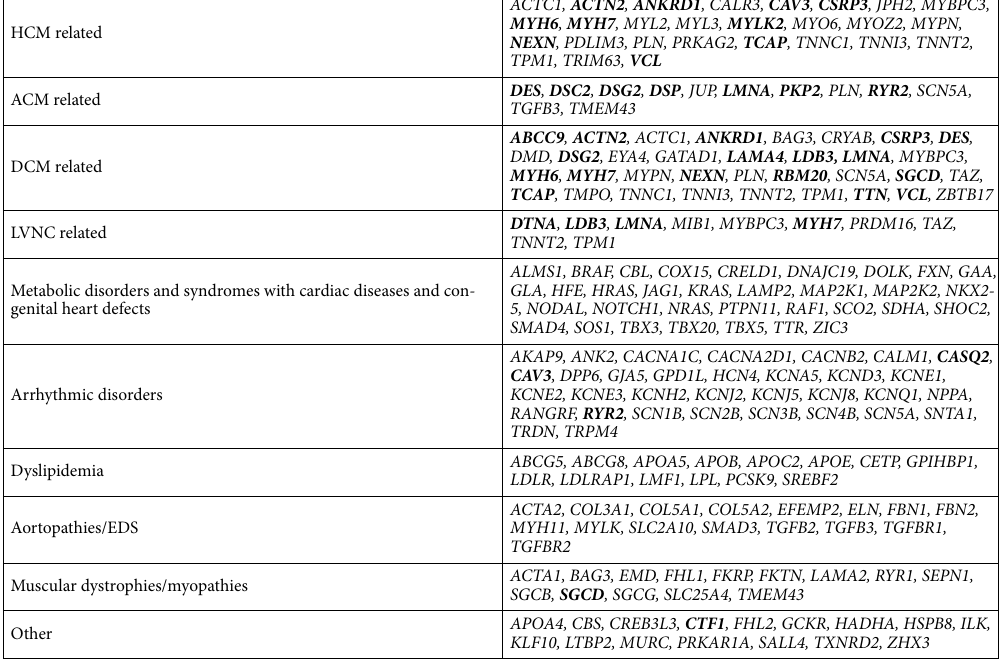
Table 1. Cardiac structure- and function-related genes sequenced in the panel classified by disease associations. Genes in bold had potentially disease related variants in sudden cardiac death victims. ACM arrhythmogenic cardiomyopathy, DCM dilated cardiomyopathy, EDS Ehlers-Danlos syndrome, HCM hypertrophic cardiomyopathy, LVNC left ventricular non-compaction